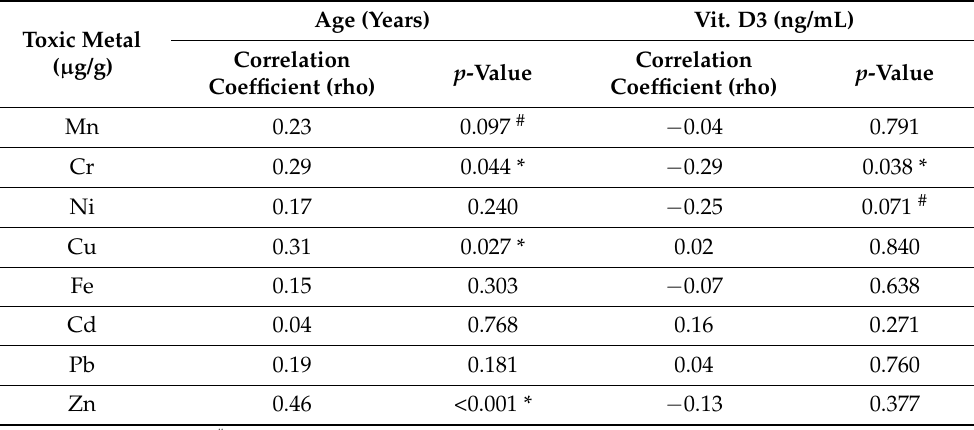
Table 5. Correlations between levels of toxic metals and continuous variables such as age and vitamin D3 concentration in patients residing in the LG Cooper Area ( n = 49). Spearman correlation analysis was used for testing the